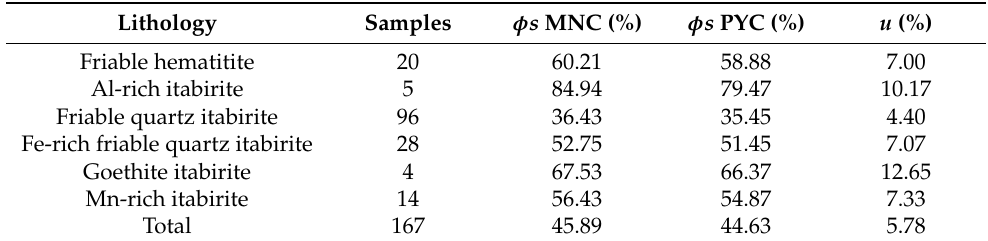
Table 3. Average pore saturation ( φ s ) and moisture ( u ) by lithology and measurement method— weathered samples—subgroup 1 (friable).